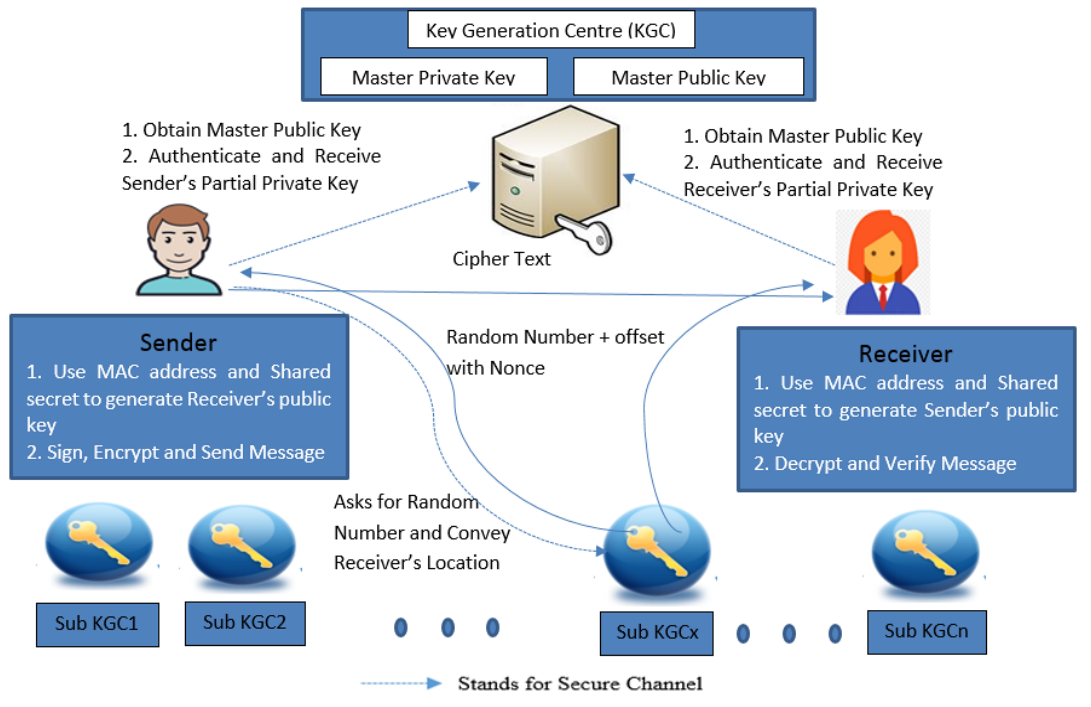
Figure 3. Improved IBE System without Key-Escrow Problem